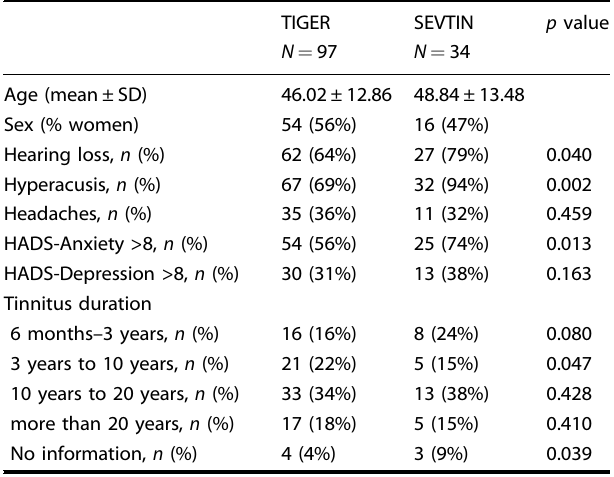
Table 1. Clinical features in Swedish patients with tinnitus for all (TIGER) and severe tinnitus (SEVTIN)